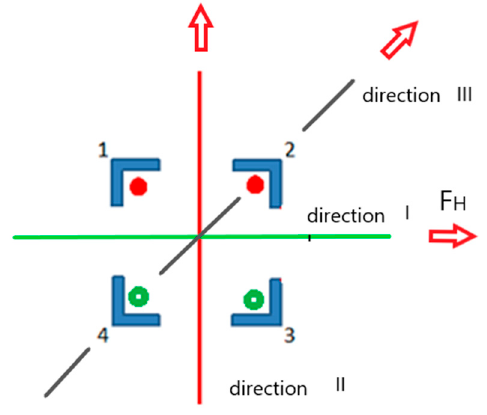
Figure 5. Direction of the load force in tower A.